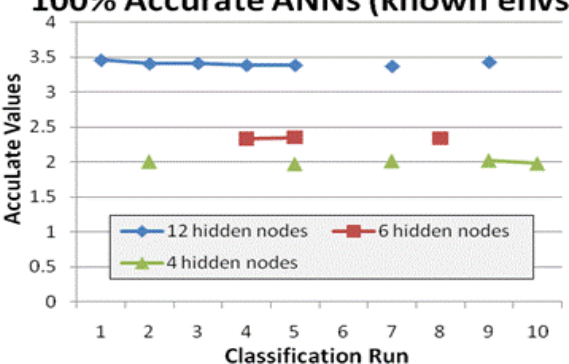
Fig. 8: AccuLate Values for 100% Accuracy Known Envs.